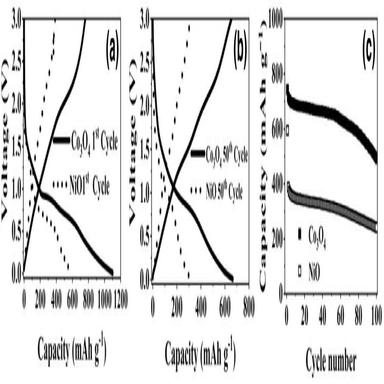
Voltage signature of the 1st cycle (a) and of the 50th cycle (b) of the galvanostatic cycling test of the Li/LP30/NiO (dotted line) and of the Li/LP30/Co3O4 (straight line) cells. (c) Cycling behavior of the Li/LP30/NiO (white) and of the Li/LP30/Co3O4 (black) cells (c).